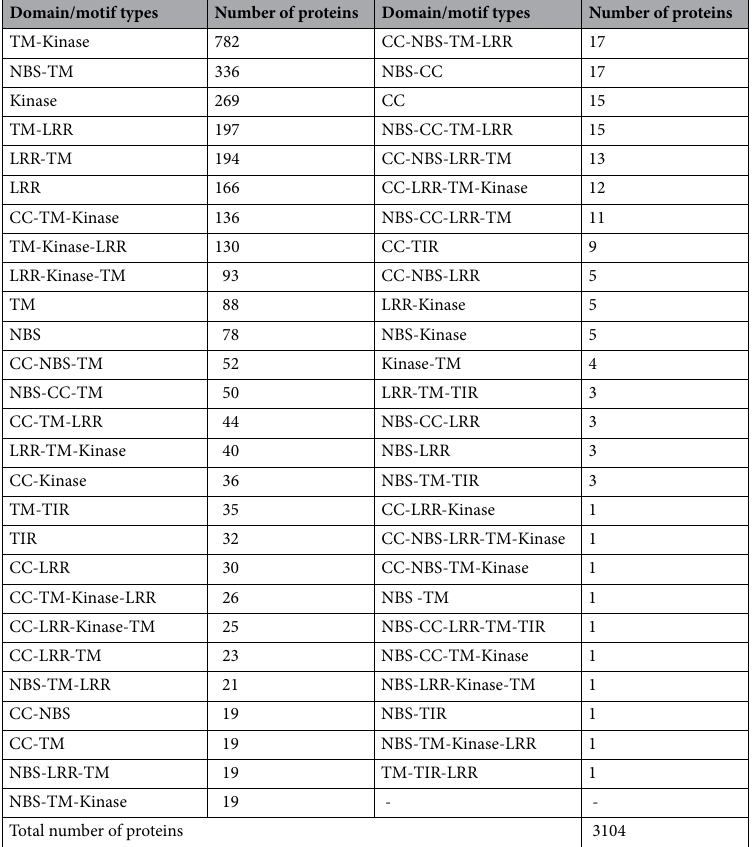
Table 5. Prediction of R genes domains/motifs present in the proteins identified from the A. occidentale genome using DRAGO v.2 and Plant resistance gene